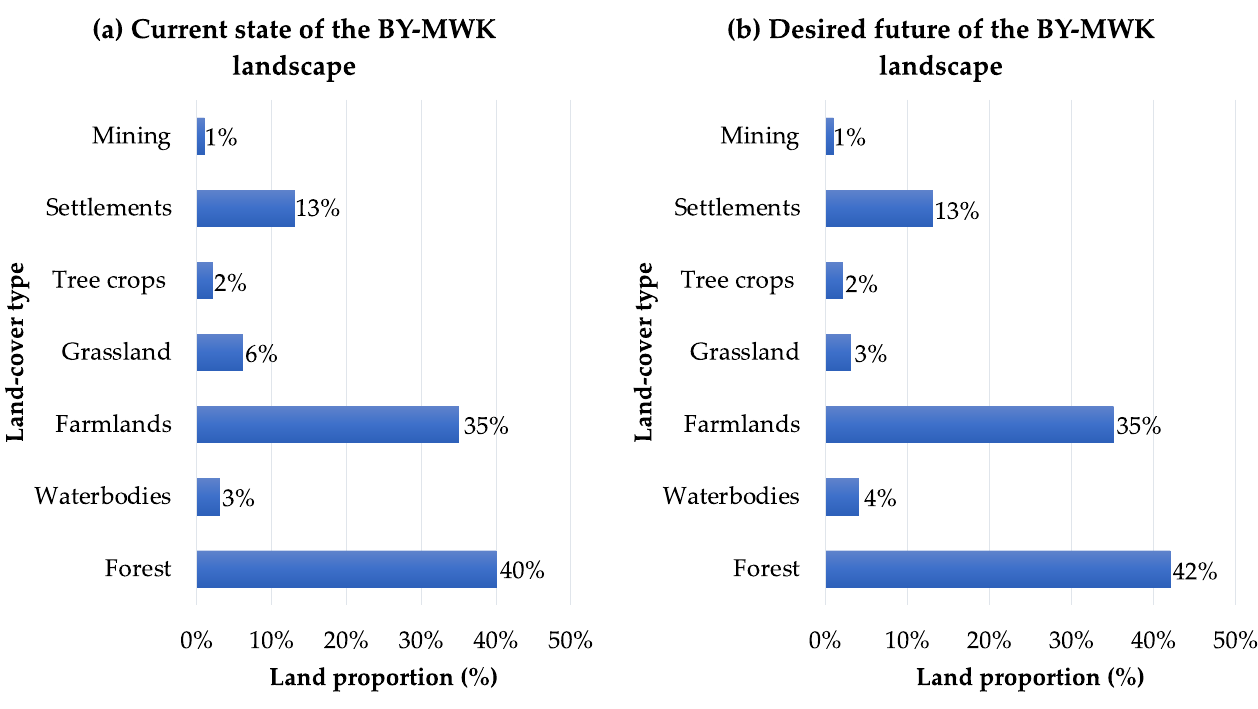
Figure 7. Perceived current state ( a ) and desired future composition ( b ) of the Builsa Yenning (BY)-Moagduri Wuntanluri Kuwomsaasi (MWK) landscape as visualised by institutional